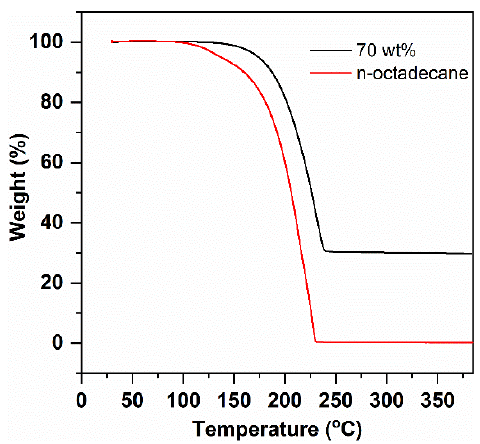
Figure 6. Thermogravimetric (TG) curves of pure n-octadecane and 70 wt% n-octadecane/FS PCC.